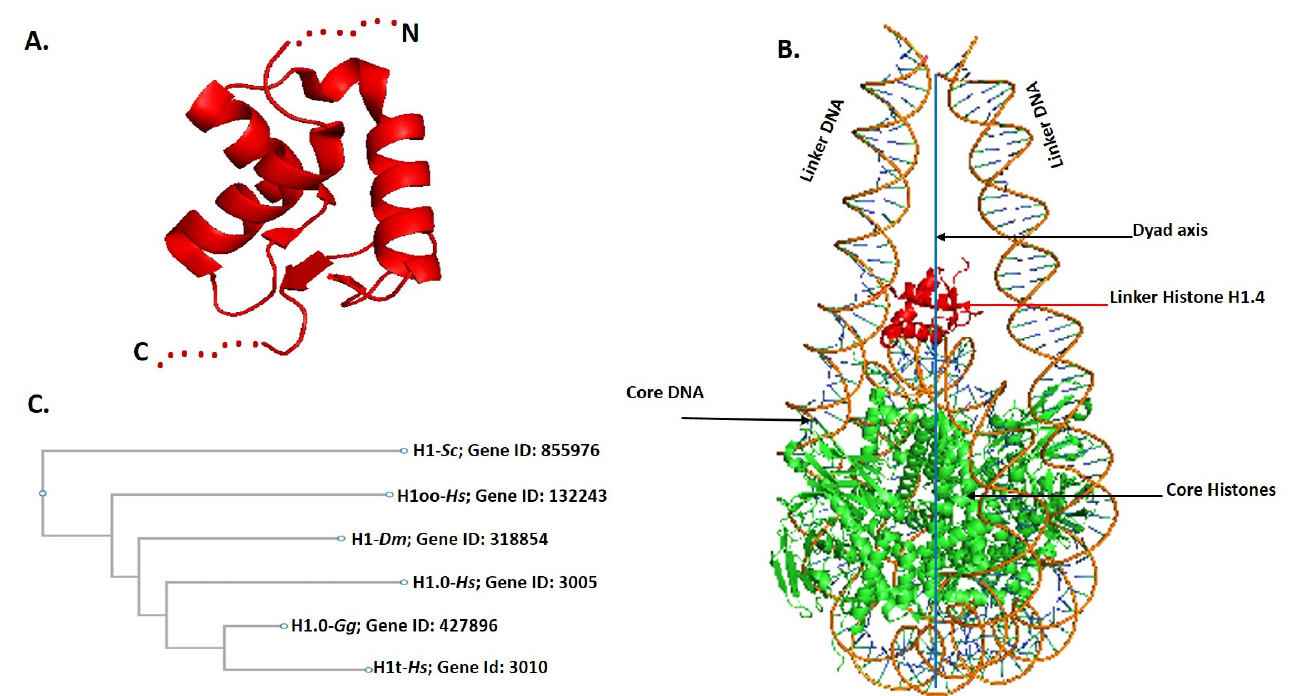
Figure 1. ( A ) General structure of linker histone with central globular domain (red), unstructured N-terminal domain (dotted red), and long C-terminal domain (dotted red). ( B ) CryoEM structure of the nucleosome with linker histone H1.4 prepared by PyMol using PDB ID: 7k5y. The central portion is octamer of histone (green), Linker histone H1.4 (red). ( C ) Phylogeny tree of linker histone from Saccharomyces cerevisiae ( Sc ), Homo sapiens ( Hs ), Drosophila melanogaster ( Dm ), Gallus ( Gg ) .